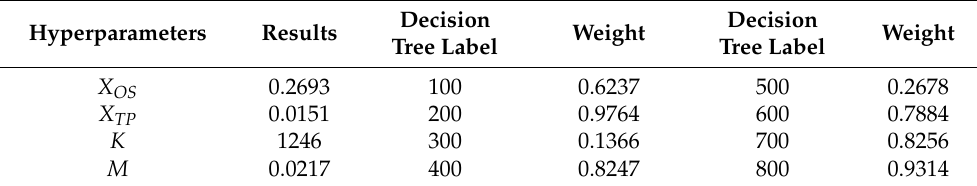
Table 5. The optimization model results and some decision tree weights of the proposed method.